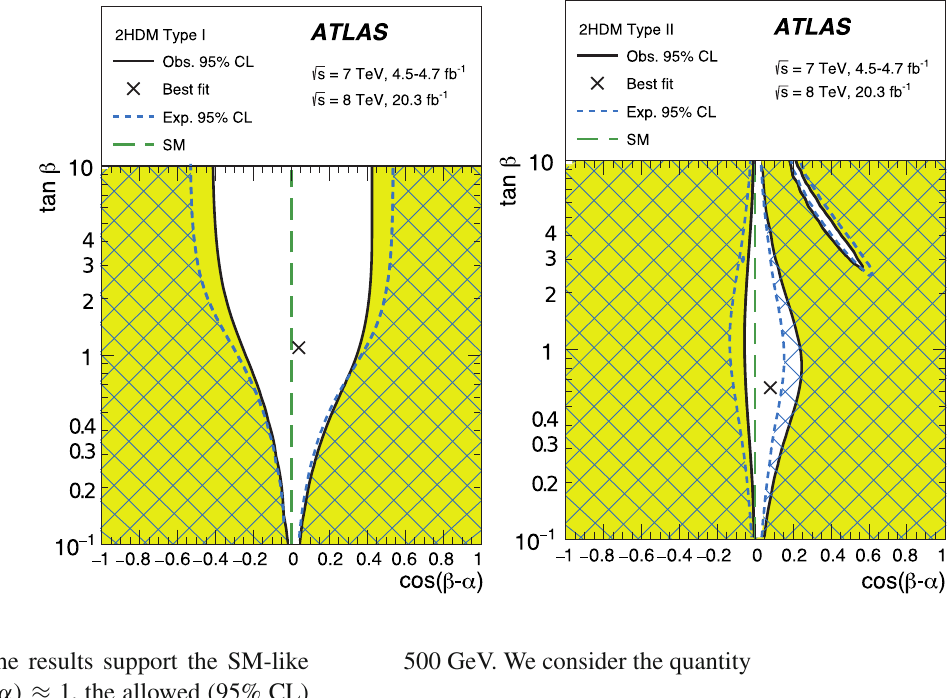
Fig. 25 ATLAS regions of the [cos (β − α) , tan β ] plane for the 2HDM Model I ( left ) and Model II ( right ) excluded by fits to the measured rates of Higgs-boson production and decays. (Reprinted with kind permission from JHEP and the authors, Fig. 5 of